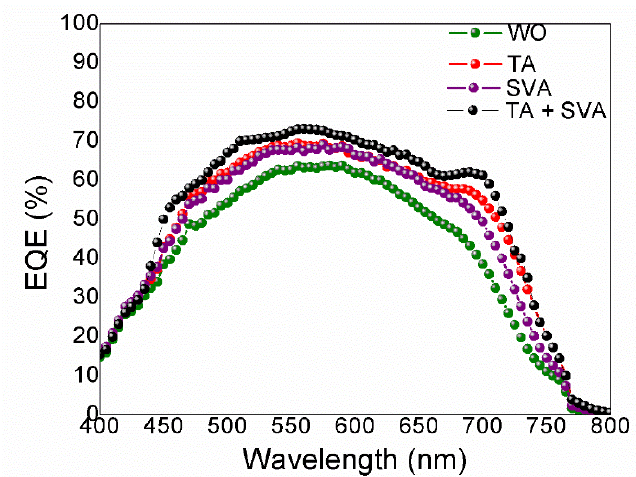
Figure 7. EQE spectra of OSCs devices based on DRCN5T:[70]PCBM films with different treatments. Thermally treated (TA) at 120 °C during 10 min and SVA with chloroform vapor for 60 s.